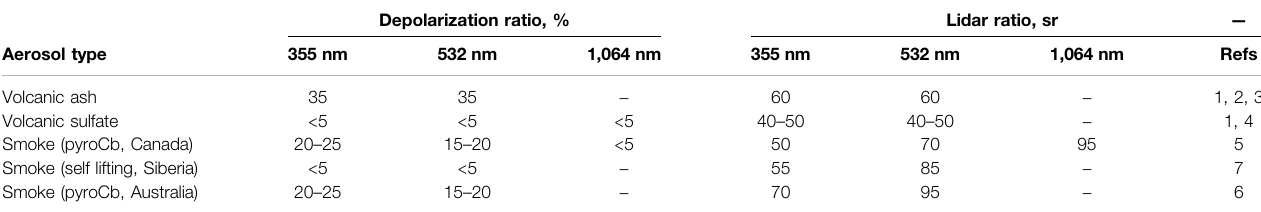
TABLE 2 | Particle linear depolarization ratio and lidar ratio (extinction-to-backscatter ratio) at 355, 532, and 1,064 nm for different stratospheric aerosol types and, in the case of smoke, for different summer smoke events (Canada, 2017; Siberia, 2019; Australia, 2020). The lifting process (pyroCb activity vs self-lifting) can be identi fi ed by the depolarization ratio (sensitive to shape properties), but not by the lidar ratio (sensitive to chemical composition). The given values are taken from the literature: 1. Prata etal.(2017),2.Großetal.(2012),3.Ansmannetal.(2010),4.Mattisetal.(2010),5.Haarigetal.(2018),6.Ohneiseretal.(2020),7.Ohneiseretal.(2021).Theaerosol-typing scheme of Kim et al. (Kim et al., 2018) considers observations presented in 1 – 4. References 5 – 7 are not